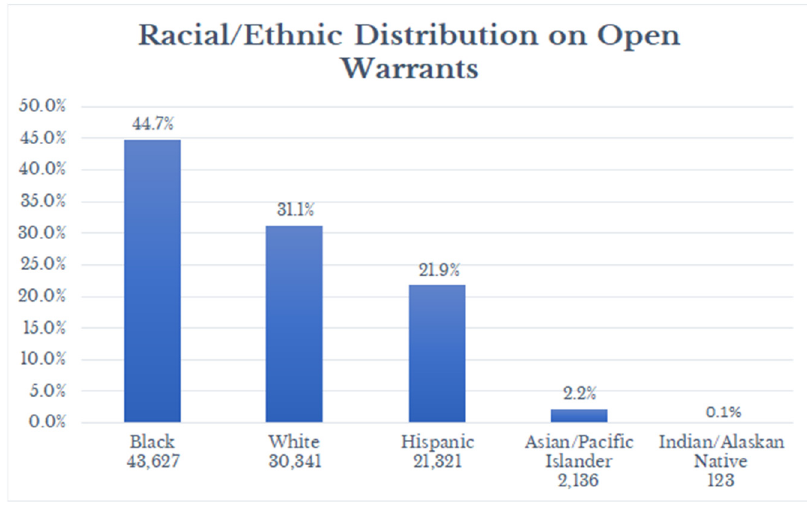
Figure 5. Racial/Ethnic Distribution on Open Warrants. Table 5. Racial/Ethnic Distribution on Open Warrants. Table 6. Distribution of Open Warrants by Race/Ethnicity and Charge Type (N = 95,842) 1 .